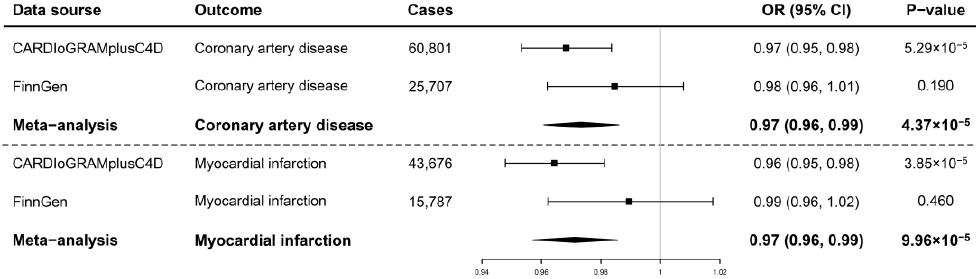
Figure 2. Association of genetically predicted serum TIMP3 levels with risk of CAD and MI. TIMP3, tissue inhibitors of matrix metalloproteinase 3; CARDIoGRAMplusC4D, Coronary Artery Disease Genome − Wide Replication and Meta − Analysis plus the Coronary Artery Disease Genetics; OR, odds ratio; CI, confidence interval.